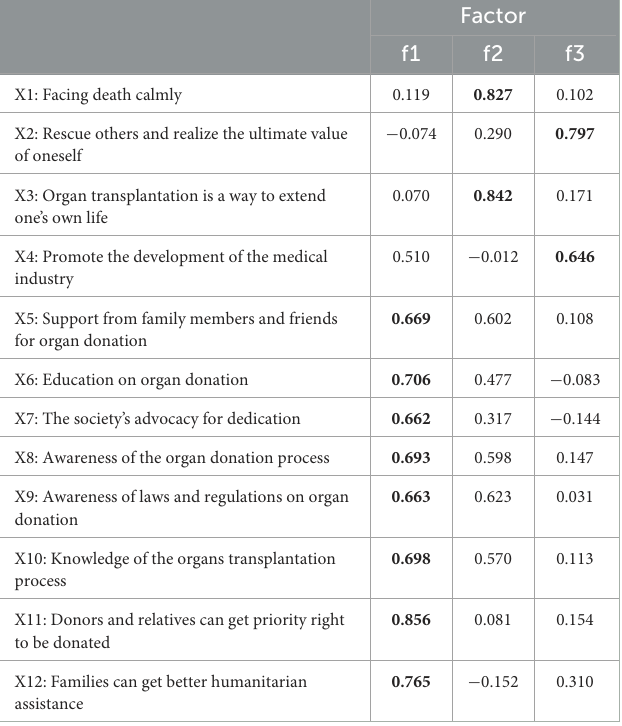
TABLE 11 Rotated component matrix (willingness to be an organ